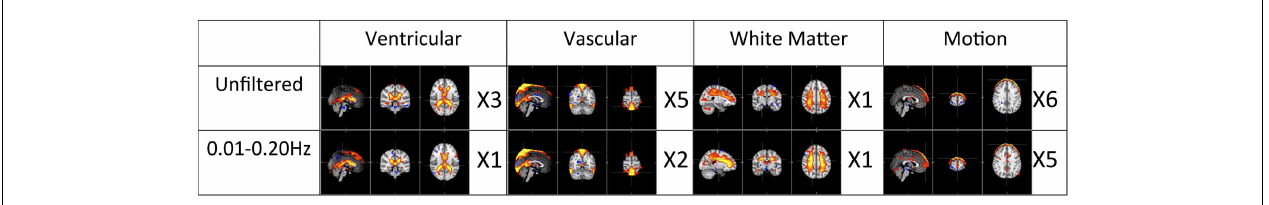
FIGURE 6 |Total number of physiological ICs identified from unfiltered vs. filtered data (0.01–0.2Hz) is categorized and listed accordingly